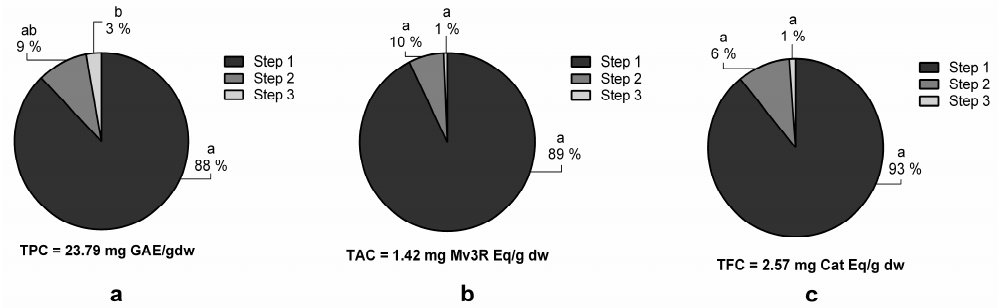
Figure 4. Effect of different extraction steps on total phenolic (TPC) ( a ), total anthocyanin (TAC) ( b ), and total flavanol (TFC) ( c ) content of organic whole red Grenache grapes. The total amount after three consecutive extractions is expressed as mg of phenolic equivalents per gram of dry weight (mg Eq/g dw) ± SD (n = 3). Letters represent significant differences (one-way ANOVA; p < 0.05). Abbreviations: gallic acid equivalents (GAE), malvidin-3- O -rutinoside (Mv3R) and catechin